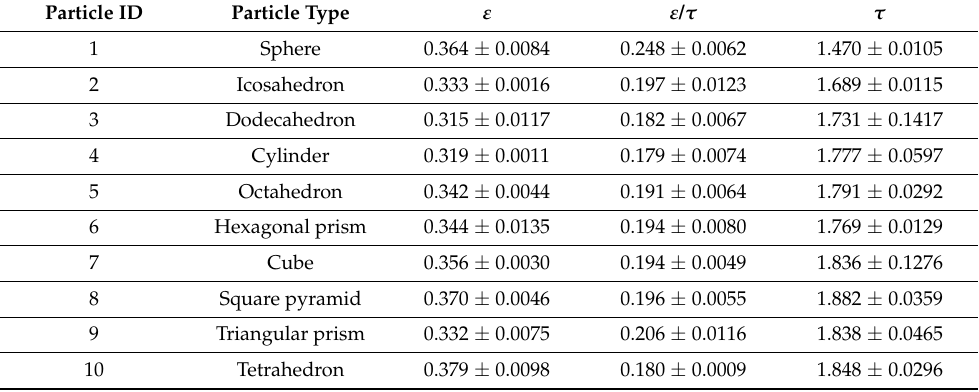
Table 2. Results of ε , ε / τ , and τ for different particle shapes and their deviation among three